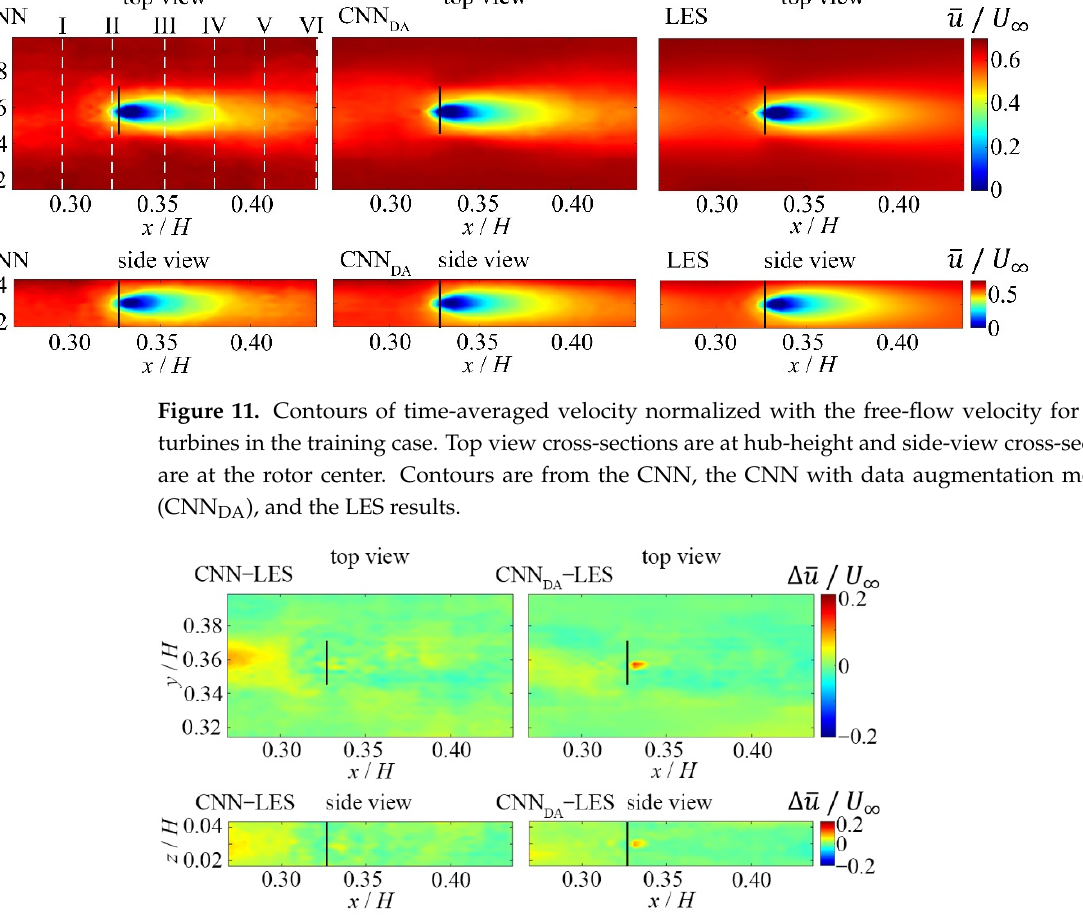
Figure 12. Contours of velocity difference between CNN and LES results normalized with the free- flow velocity for wind turbines in the training case. Top view cross-sections are at hub-height and side-view cross-sections are at the rotor center.